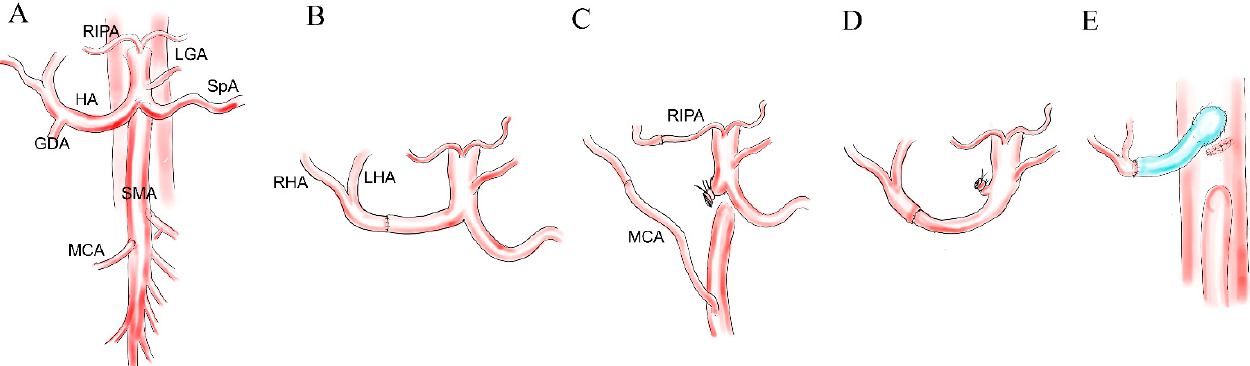
Figure 2. Reconstruction of the hepatic artery. ( A ) Basic anatomy of the relevant vessels in HA resection. ( B ) Direct end-to-end anastomosis. ( C ) Transposition of the MCA and RIPA to be anastomosed with the RHA and LHA. ( D ) Transposition of the SpA to be anastomosed with the proper HA. ( E ) Graft interposition from the aorta to the stump of the proper HA. HA, hepatic artery, RIPA, right inferior phrenic artery, SpA, splenic artery, GDA, gastroduodenal artery, SMA, superior mesenteric artery, MCA, middle colic artery, LGA left gastric artery, RHA, right hepatic artery and LHA, left hepatic